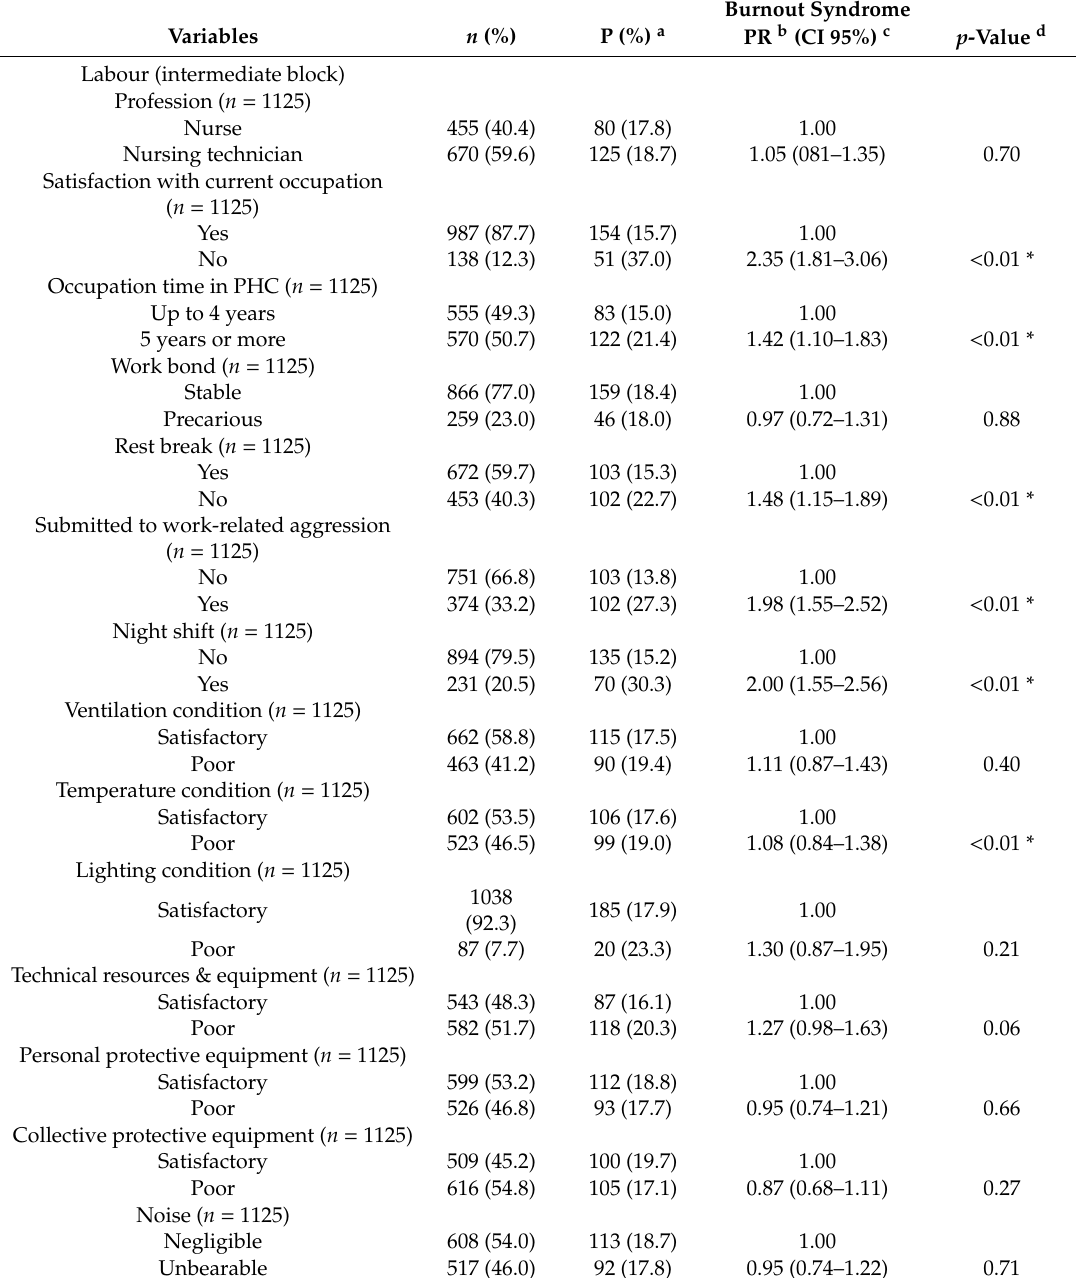
Table 3. Gross prevalence ratio of Burnout Syndrome and its 95% confidence intervals, according to labour variables in Primary Health Care nursing professionals in Bahia, Brazil in 2018 ( n =